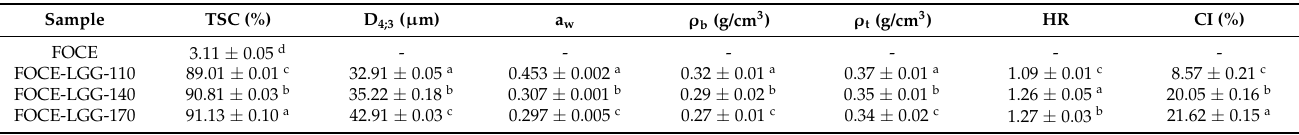
Table 2. Total solids content (TSC), particles size (D 4;3 ), water activity (a w ), bulk denisity ( ρ b ), tapped denisty ( ρ t ), Hausner Ratio (HR), and Carr’s Index (CI) of FOCE